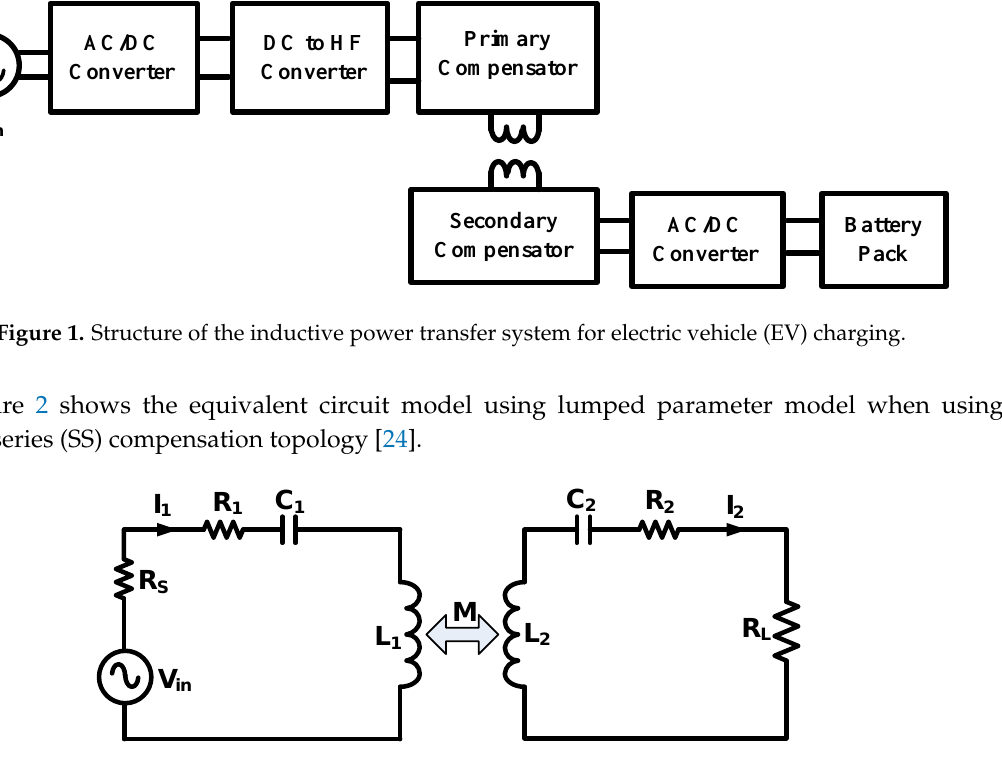
Figure 2. Wireless power transfer (WPT) equivalent circuit using a lumped parameter